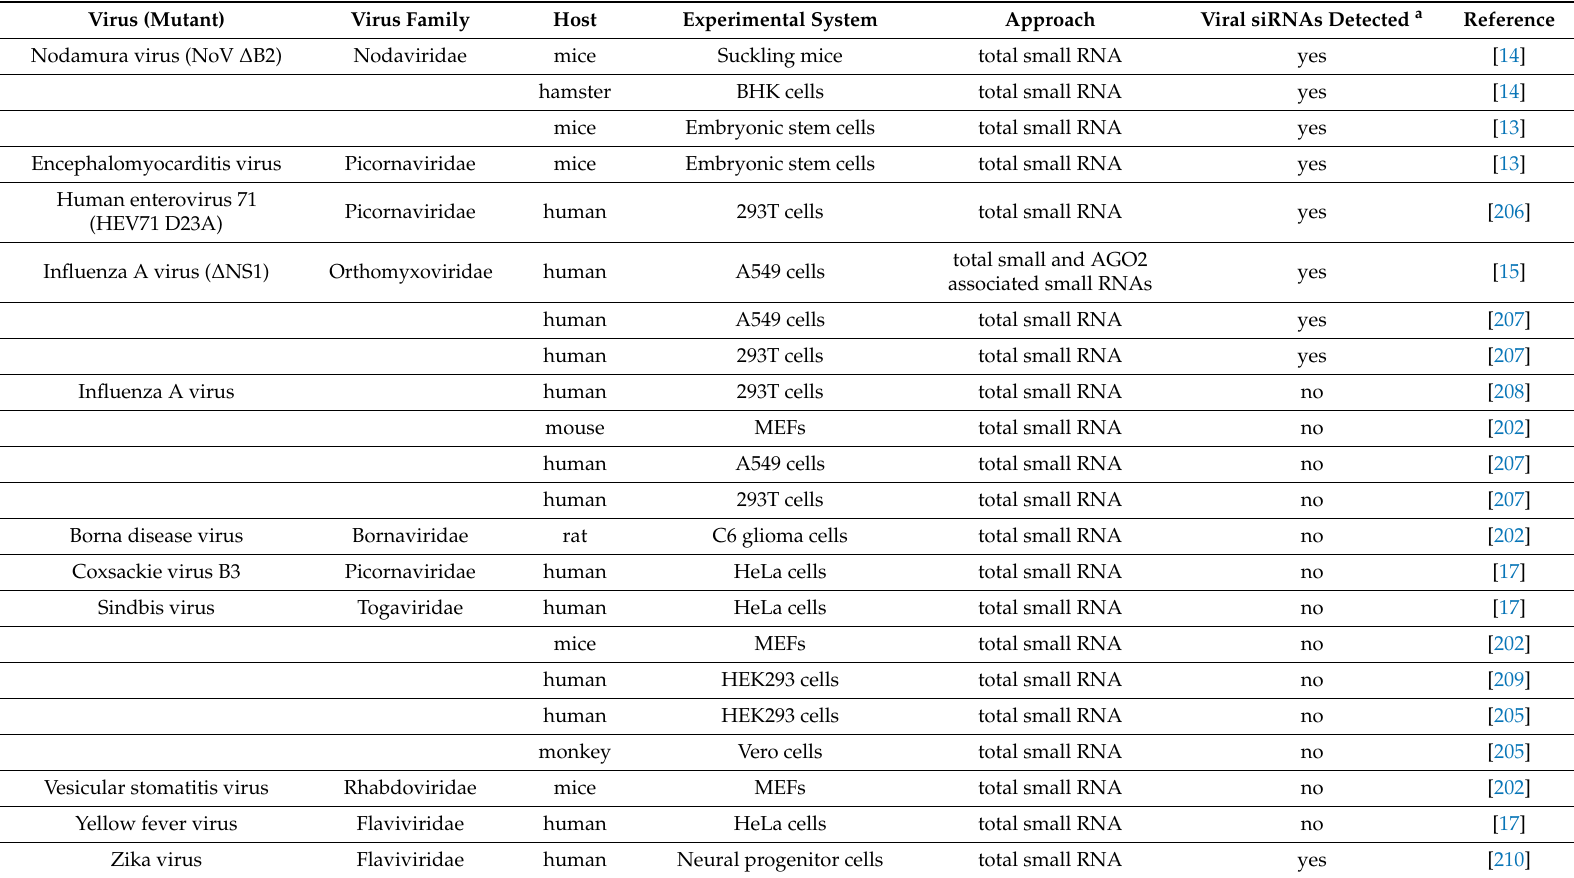
Table 1. Recent studies reporting viral small RNA profiles in mammalian experimental